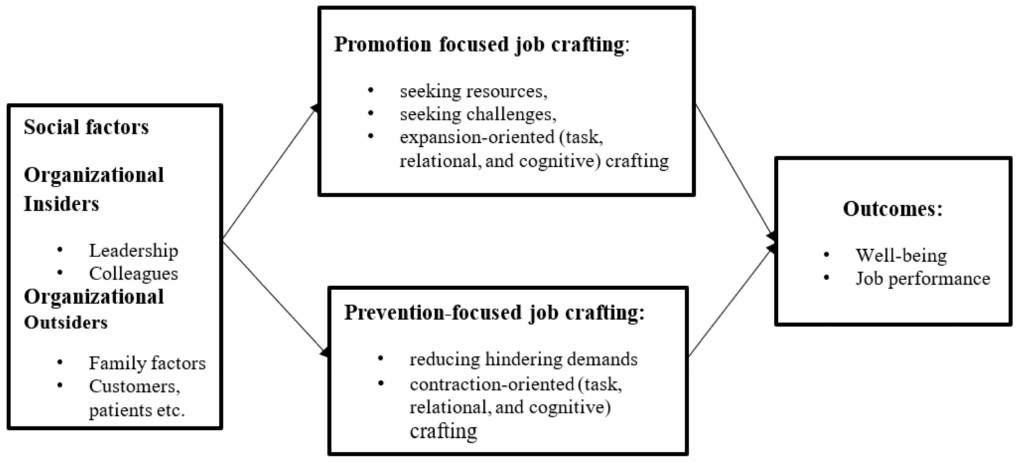
Figure 1. Hypothesized